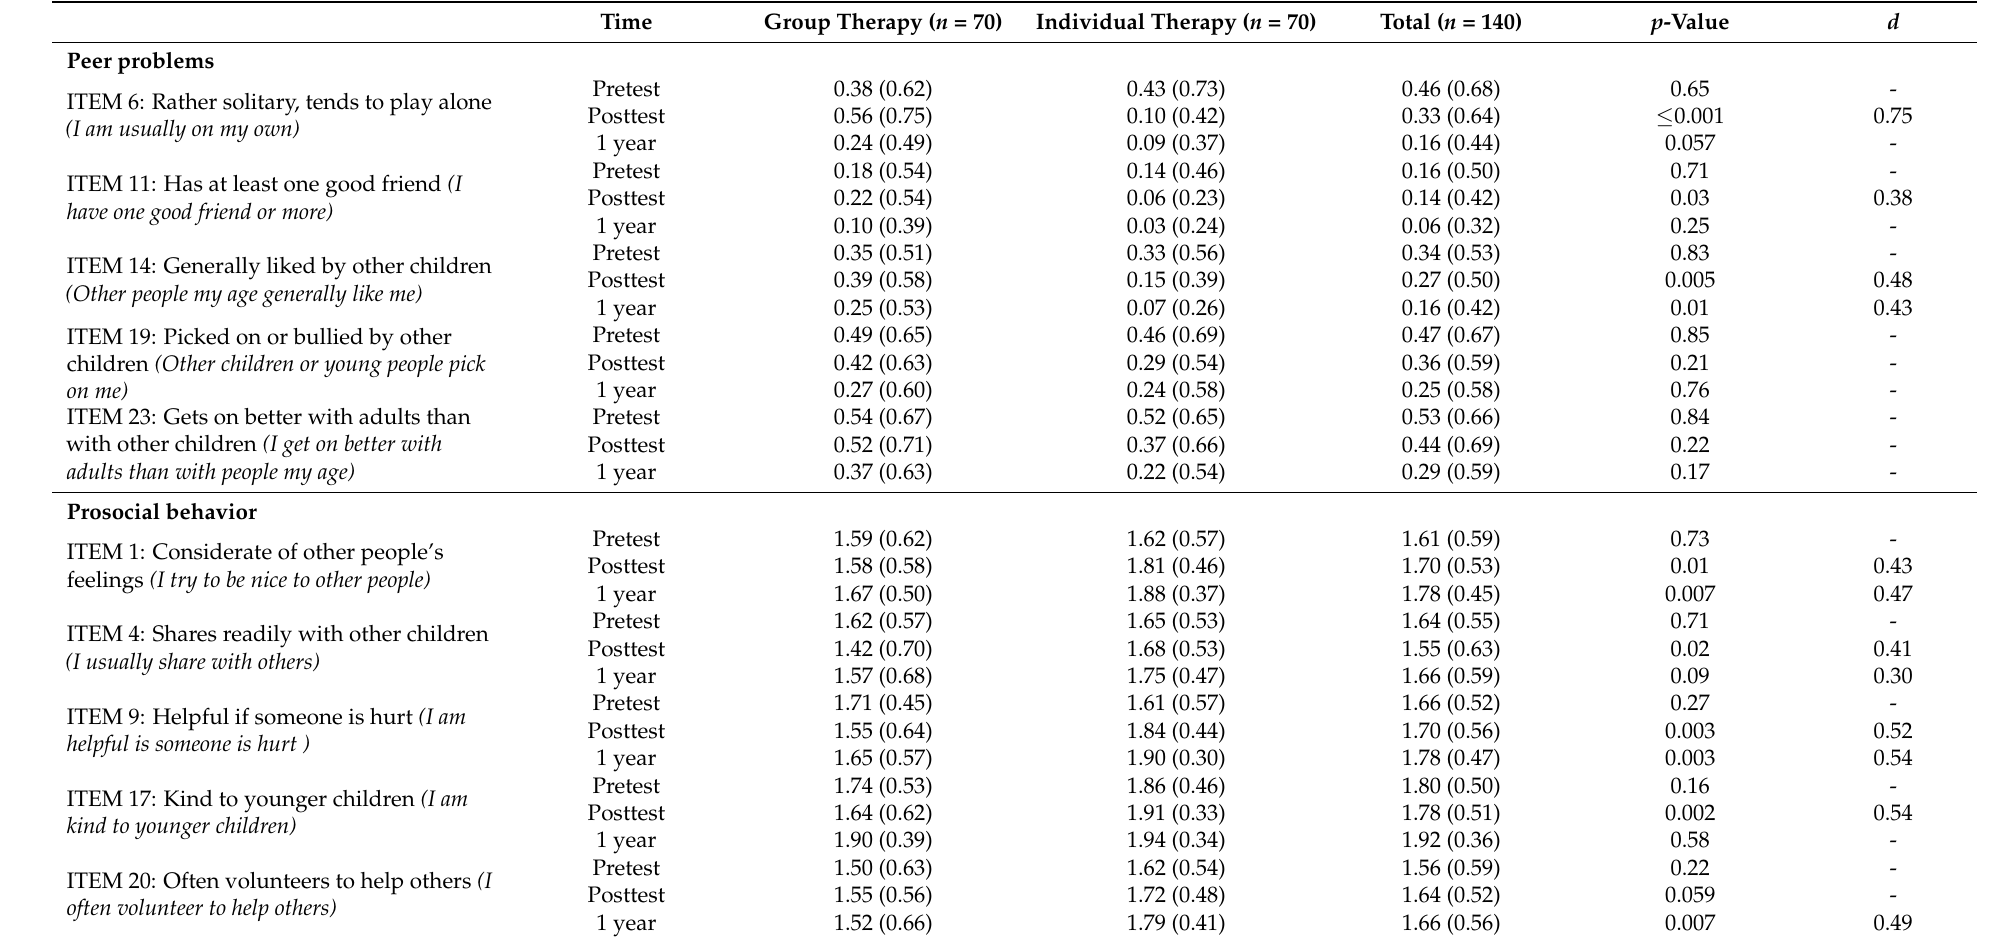
Table 4. Comparison of items from peer problems and prosocial behavior subscales by time and by intervention